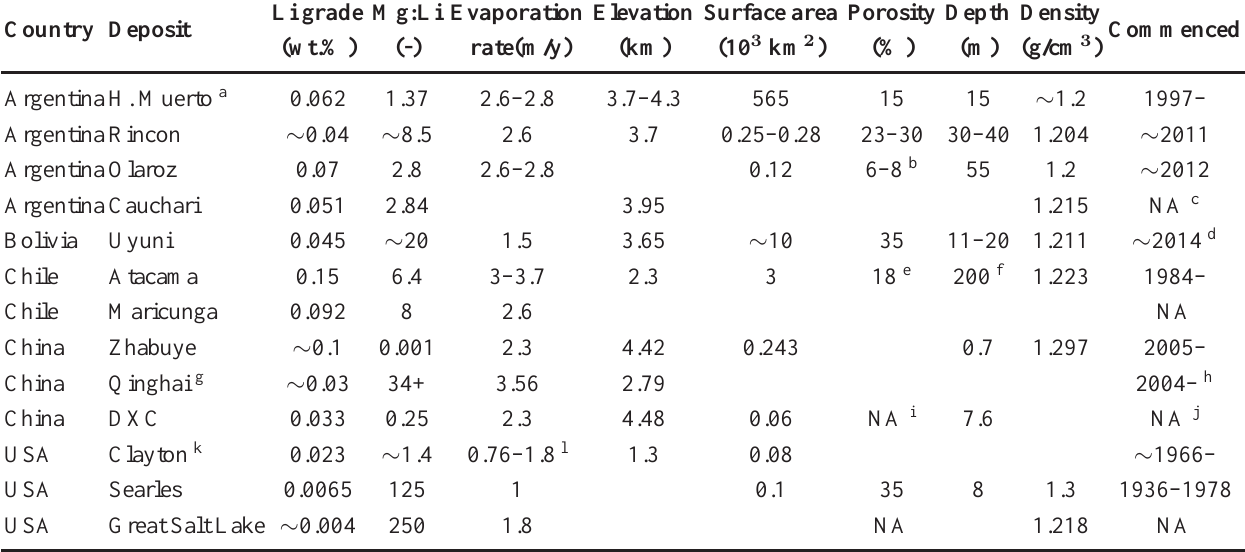
Table 1. Brine basin information